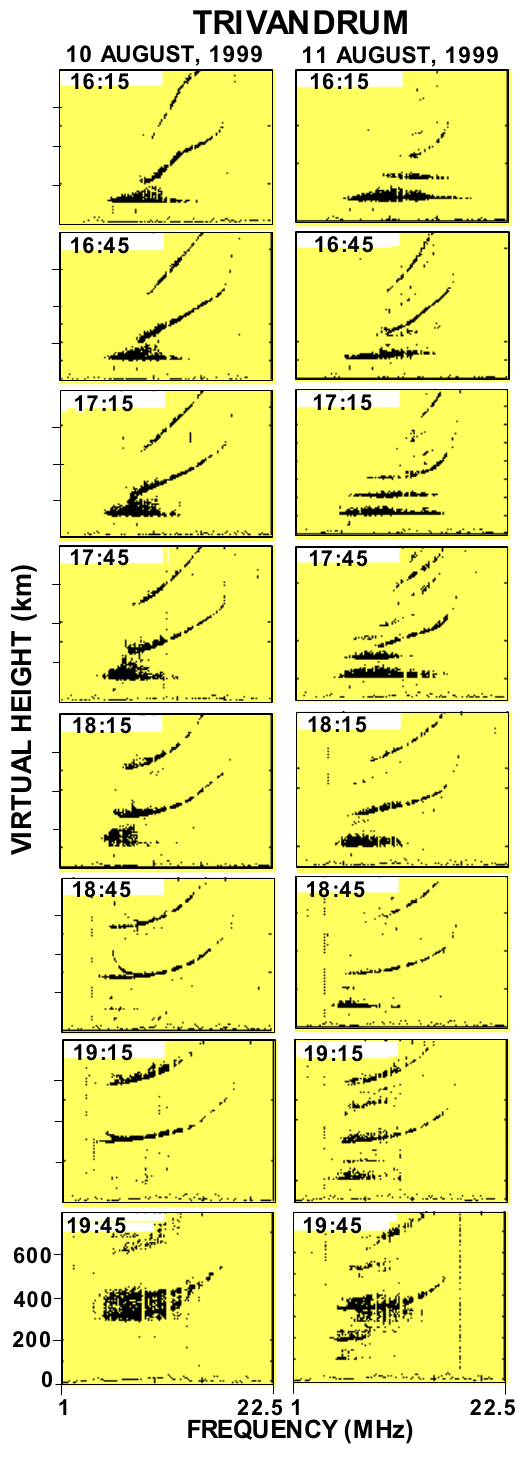
Fig. 1. The sequence of ionograms from Trivandrum on 10 and 11 August 1999 corresponding to the same time on both the days. The E-region behaviour during 17:15–18:15IST is distinctly different on both the